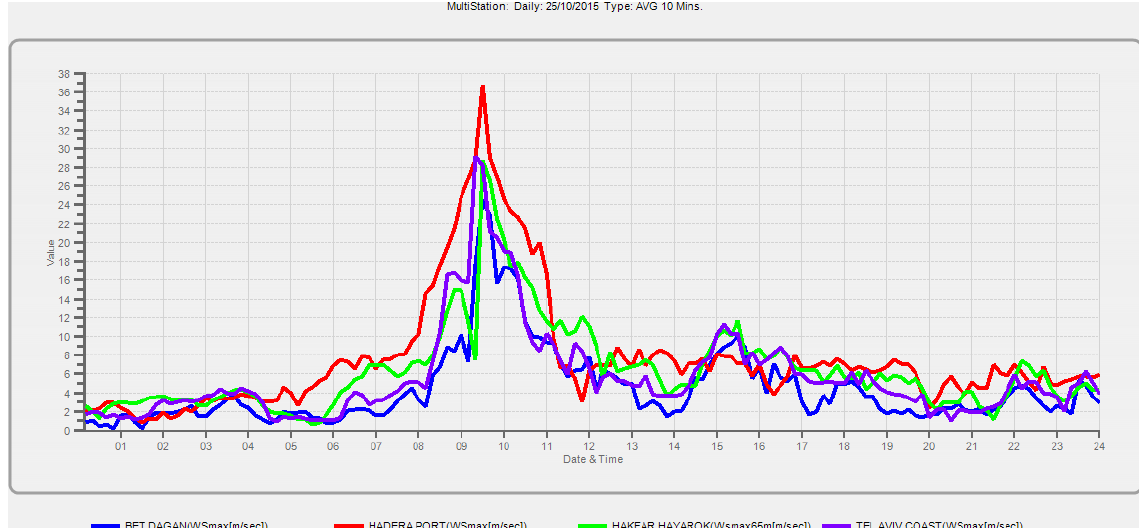
Figure 2. Wind speed at four different stations along Israel. Bet Dagan (in blue) is located 12km southeast of Tel Aviv. The port of Hadera (red) is located on the coastline, 45km north of Tel Aviv. Hakfar Hayarok (green) is 5km northeast of Tel Aviv, and Tel Aviv coast (purple) is located on the Mediterranean coastline. All stations recorded an abrupt and short-lived increase in wind speed around 10:00LT, indicating the passage of the gust front. Data courtesy of the